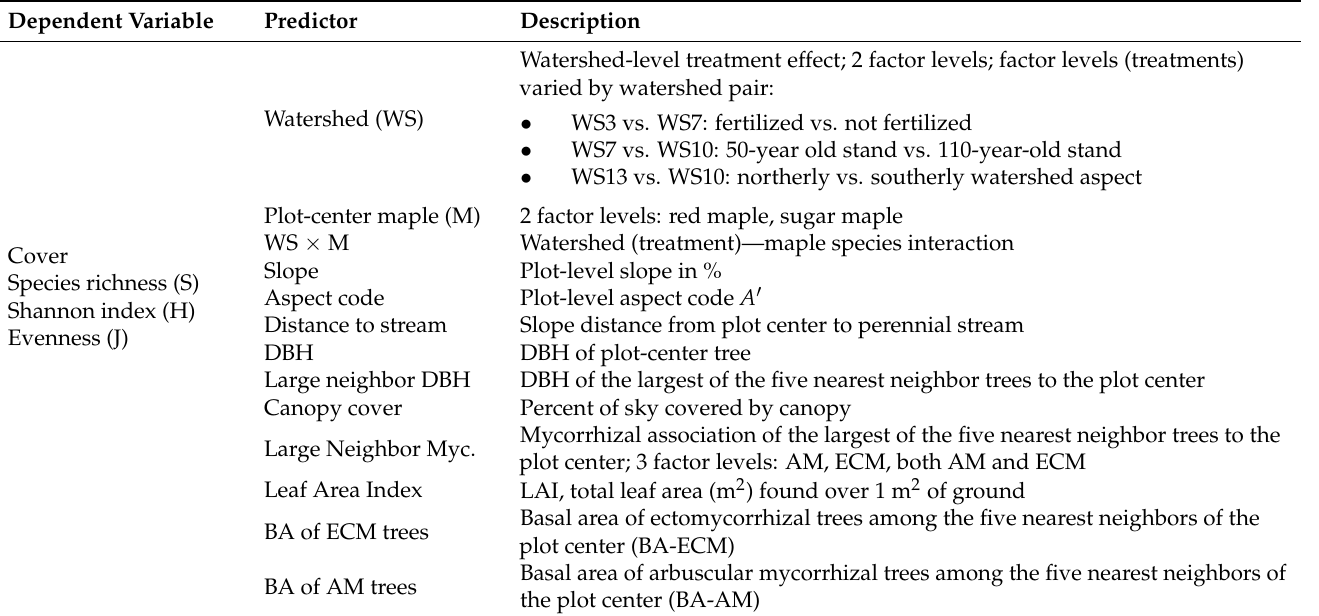
Table 2. Dependent and independent (predictor) variables used in ANOVA for summer and spring herb-layer datasets. The four watersheds in this study were grouped into pairs to avoid confounding the treatment effect of interest with other watershed-level differences. In total, 12 models were run for the summer and spring dataset, respectively. Dependent